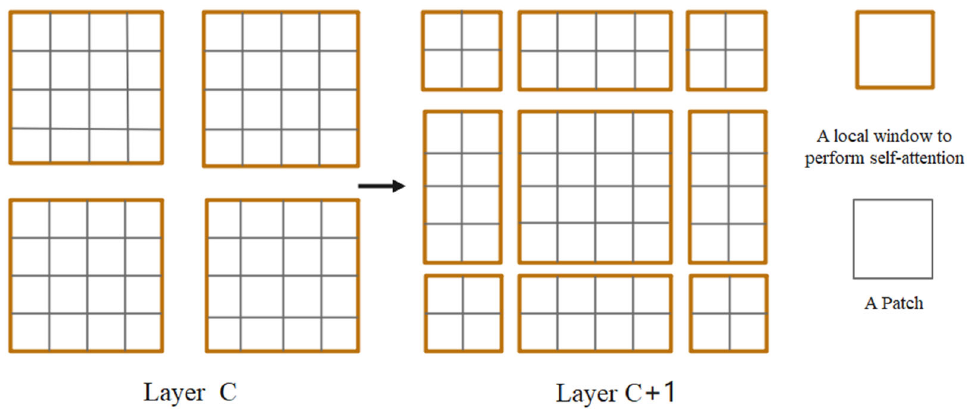
Figure 3. Illustration using a shift window method for self-attention calculation. W-MSA on the left; SW-MSA on the right.